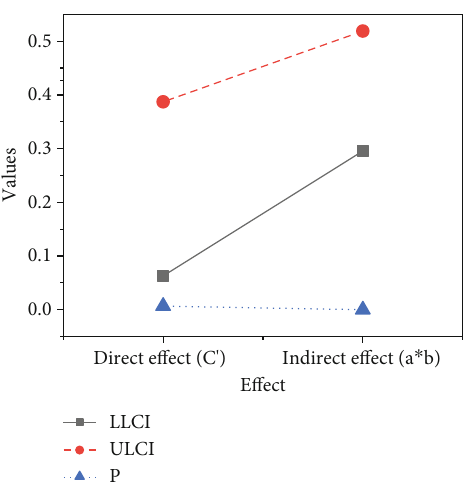
Figure 5: The moderating e ff ect of EU on the relationship between TL and